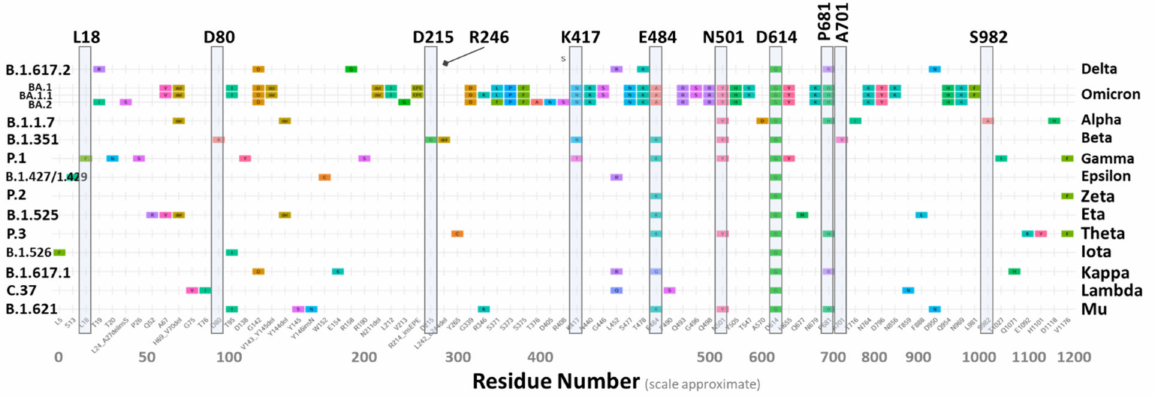
Figure 1. Selected SARS-CoV-2 dominating variants and mutations. Vertical shaded bars indicate variants examined in this investigation. Table modified from WHO Webpage (click on link for full- scale image): https://www.who.int/docs/default-source/coronaviruse/voc_voi_current_previous.